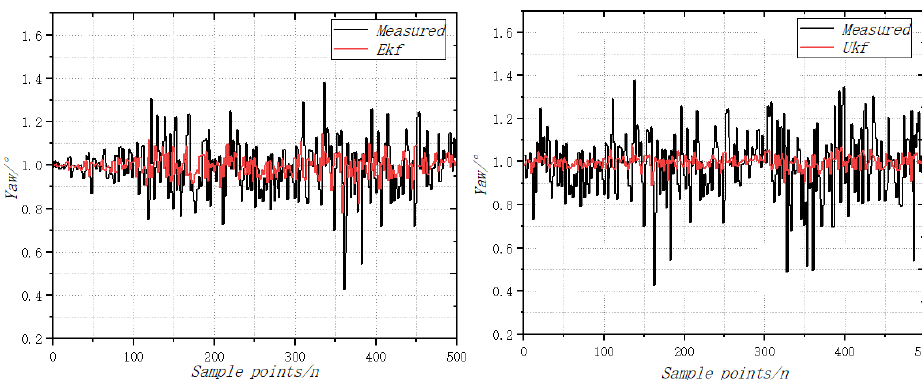
Figure 10. Variation curve of yaw vibration acceleration.